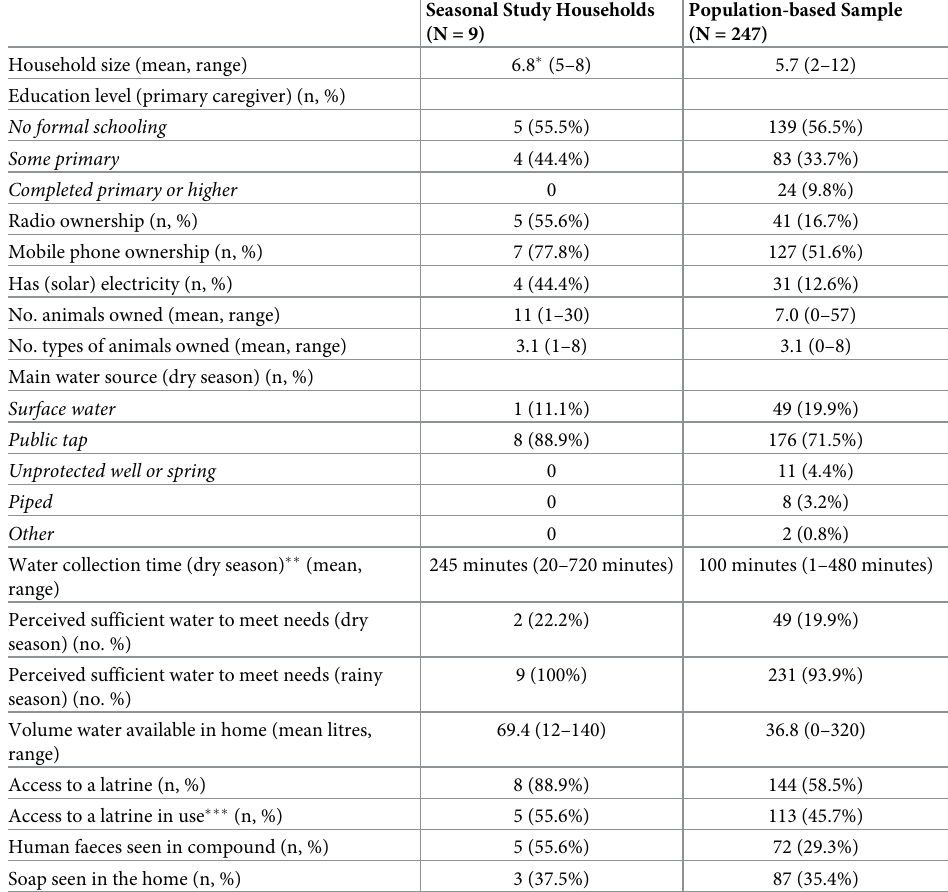
Table 1. Characteristics of Seasonal Study